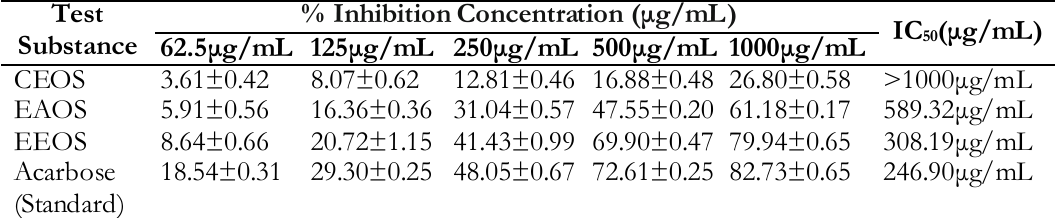
Table II. In vitro α-amylase inhibitory activity of Oncoba spinosa root extracts